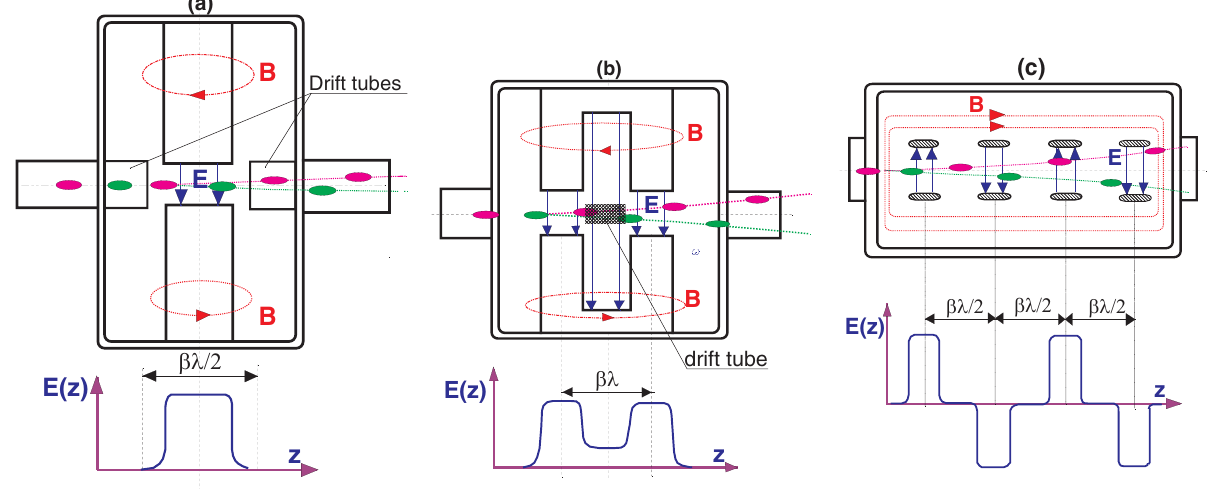
FIG. 1. (Color) Three types of rf deflectors: the half-wave coaxial (a), the profiled electrode coaxial (b), the multielectrode system (b).